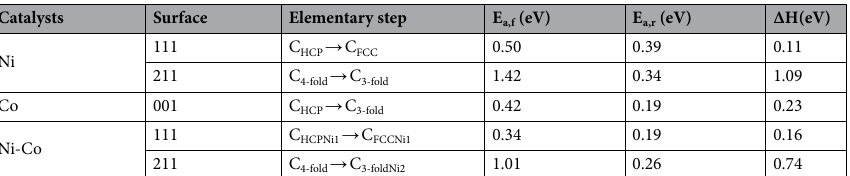
Table 3. The activation energies (E a ) of the forward (E a,f ) and reverse (E a,r ) reaction for C movement and heat of coke diffusion (∆H) on the Ni111, Ni211, Co001, NiCo111, and NiCo211 surfaces.